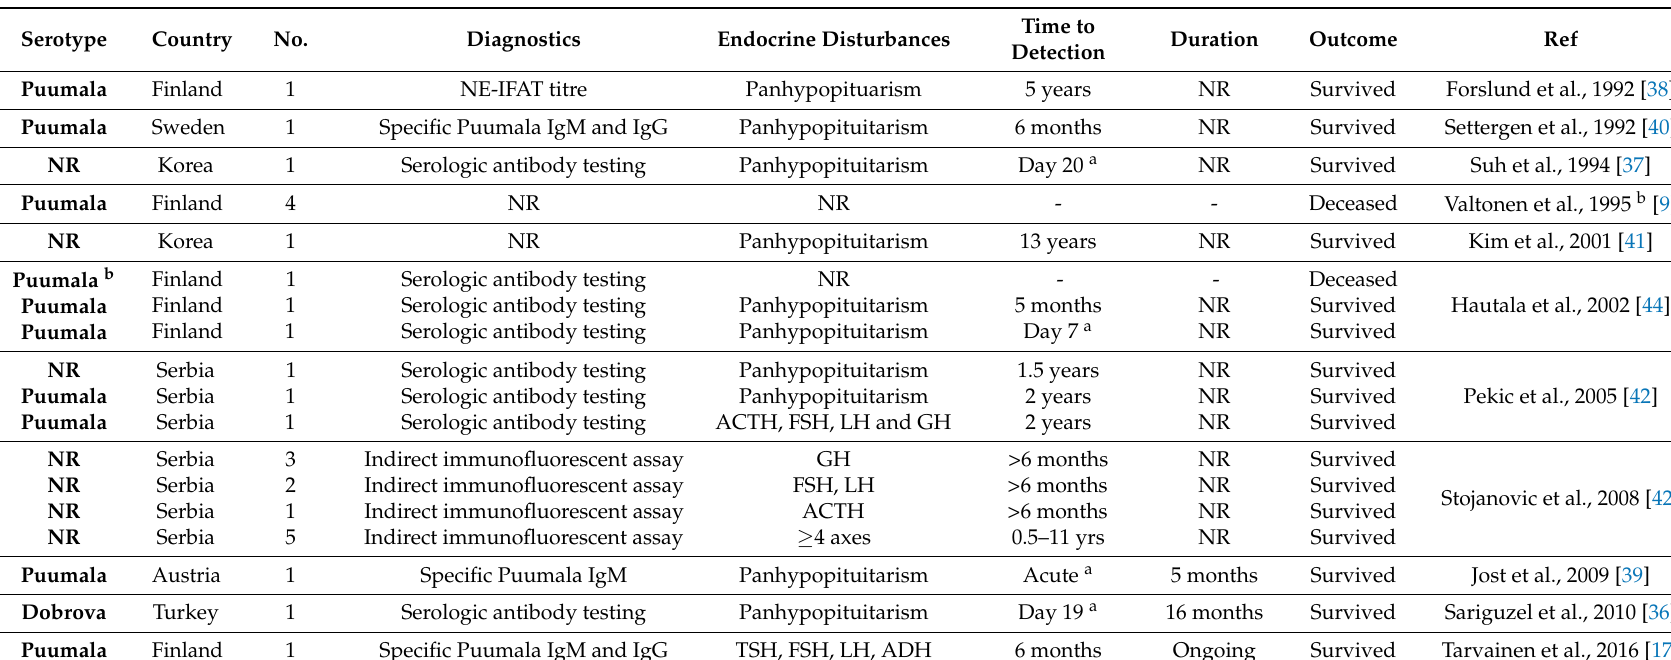
Table 2. Summary of the 28 cases of post orthohantivurs panhypopituitarism reported in literature. NE-IFAT: nephropathia epidemica indirect immunofluorescence assay